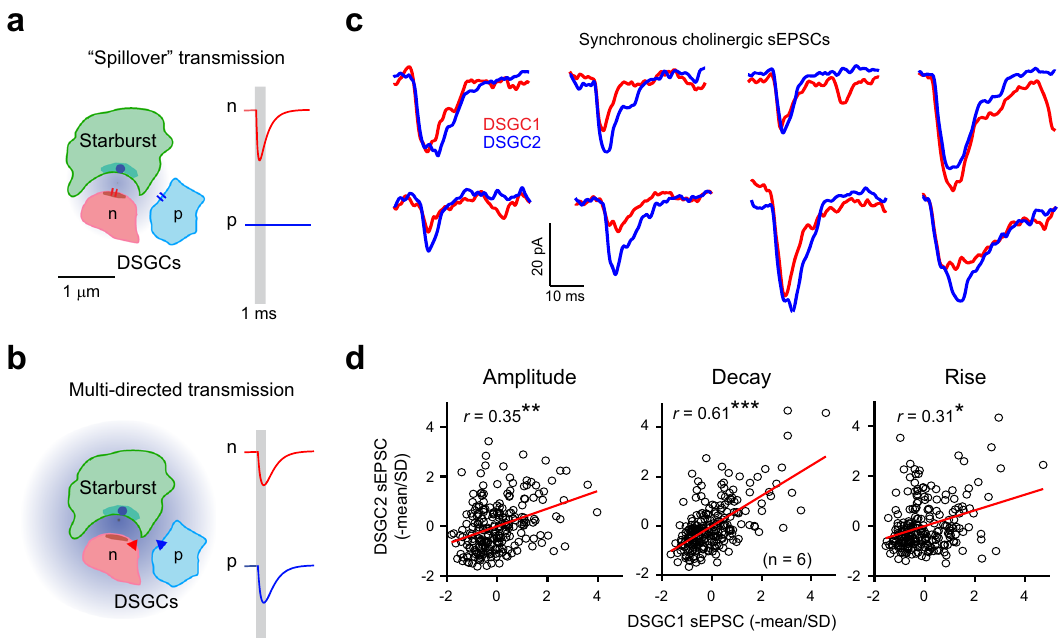
Fig. 4 Synchronized sEPSCs are similar in amplitude and kinetics indicative of multi-directed transmission. Cartoons of the tripartite complex (Fig. 1e) highlighting the differences between conventional “ spillover ” ( a ) 7,39,42,43 and multi-directed forms of ACh transmission ( b ). a ACh released from the starburst terminal rapidly activates low-af fi nity nAChRs mainly at null connections (n) giving rise to quantal EPSCs (red trace on right). A small fraction of ACh molecules also diffuse to preferred connections (p) where they mediate slower, weaker responses that generally fall below the detection limit of electrophysiological recordings (blue trace on the right). However, during more intense activity, ACh from multiple neighboring synapses can “ spillover ” and generate sizable responses at preferred sites, which could in theory explain the observed discrepancy between the anatomical and functional ACh connectivity 25,29,31 . b The central proposal here is that ACh signaling occurs over a broad spatial scale giving rise to “ multi-directed ” transmission. Unlike spillover transmission, ACh release from a single vesicle is equally ef fi cacious at preferred and null sites (right), likely mediated by receptors with high binding af fi nity (triangle). A variety of factors including the geometry of the synaptic cleft, the concentrations of ACh packaged in single vesicles and the precise biophysical properties of nAChRs (e.g., low vs. high binding af fi nity) could dictate whether spillover or multi-directed transmission occurs (Supplementary Fig. 5). c Synchronous cholinergic sEPSCs observed in DSGC pairs indicate that ACh release from a single vesicle activates two sites with comparable ef fi cacy, supporting the multi-directed transmission model ( b ). d The peak amplitudes (left), decay constants (middle) and rise times (right) of the synchronous events plotted against each other (241 events from 6 DSGC pairs, across 5 retinas). The red line indicates the line of best fi t, and r indicates the Pearson ’ s correlation coef fi cient which is signi fi cantly higher than a shuf fl ed distribution (* p = 0.043, ** p = 0.0055, *** p = 9.7 × 10 − 14 ; two- tailed z-test; see methods). The data were standardized to the mean and standard deviation (SD) to avoid artefacts that could be introduced by cell-to-cell variability in these parameters. Source data are provided as a Source Data fi le for Fig. 4c,